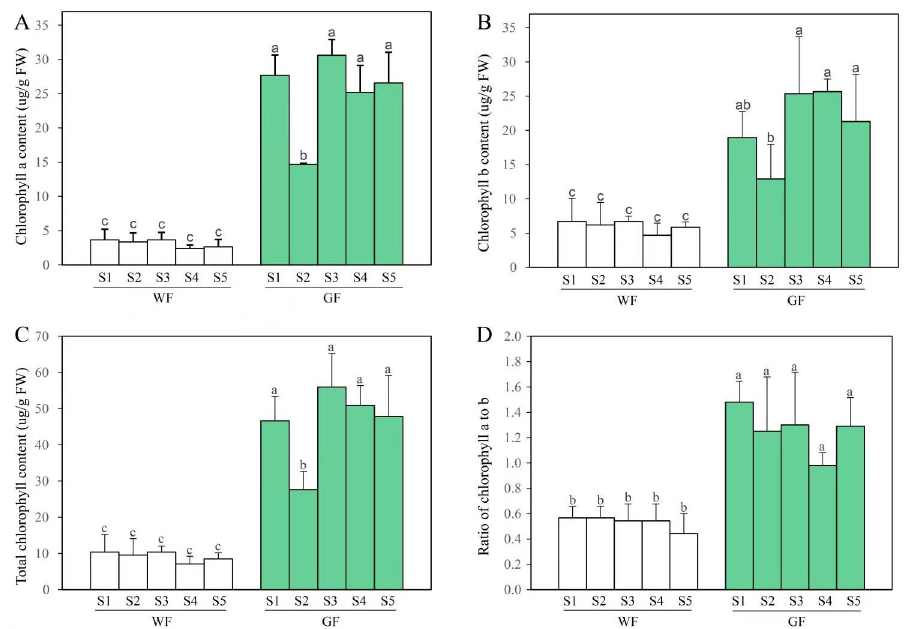
Fig 3. Chl content in flesh tissues at five developmental stages of WF and GF. A , Chl a content; B , Chl b content; C , Total Chl content; D , Ratio of Chl a to b. Each bar shows the mean values ( ± SD) of the three biological replicates, and different superscripted letters represents significant differences(P �